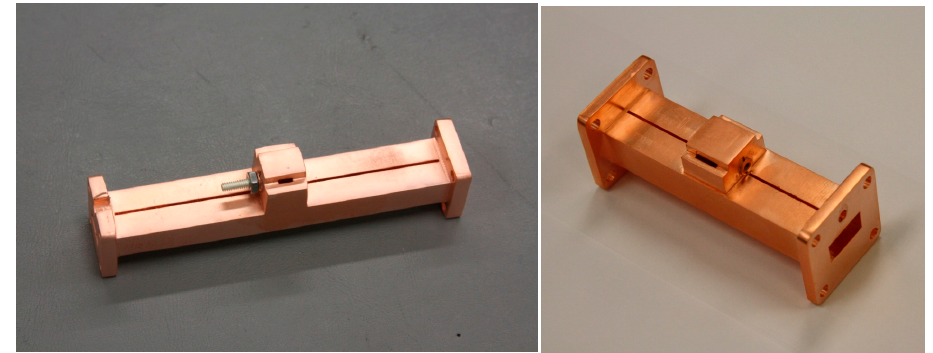
Figure 7. SLA 3D printed single cavity notch filter using WR-42 and WR-62 waveguide.